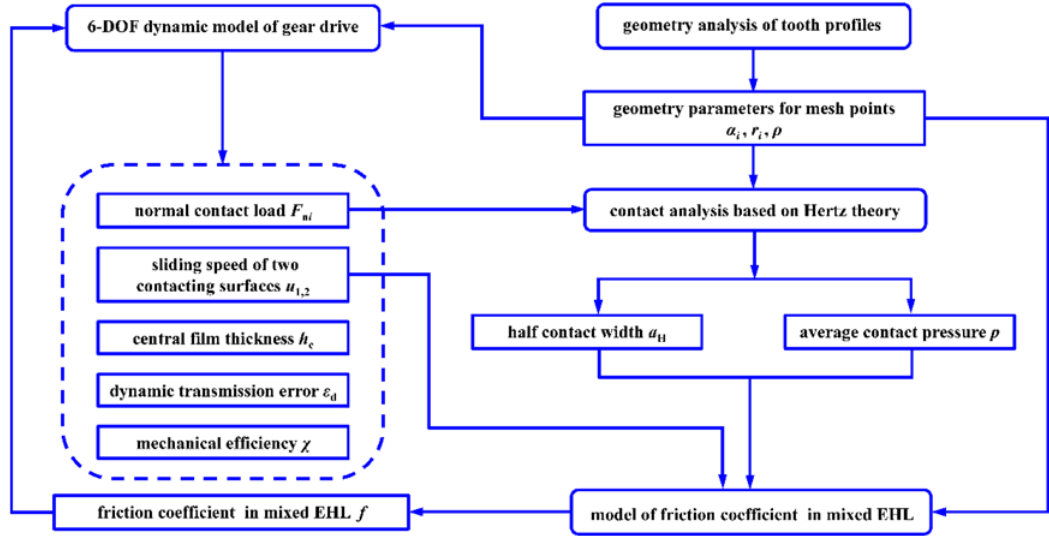
Fig. 6. Schematic of tribo-dynamics integrated model.